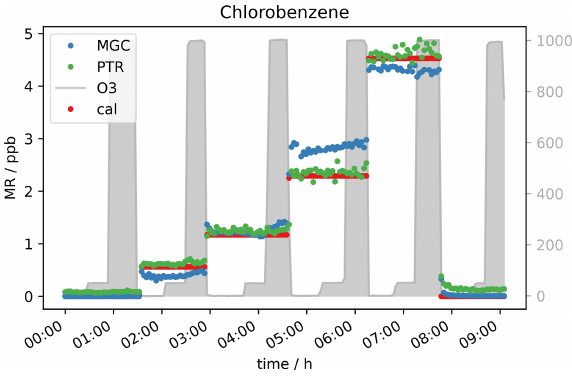
Figure 2. Effect of ozone (0, 50, 1000ppb) on GC- and PTR-MS measurements of chlorobenzene under different standard gas levels